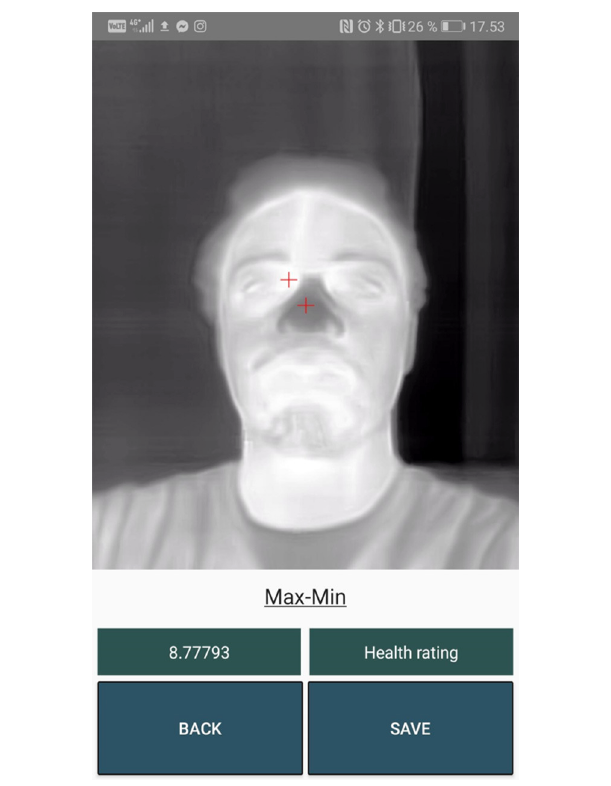
FIGURE 12 | Output markers for the RGB-Thermal Mapping algorithm. FIGURE 13 | Output markers for the Max-Min Template